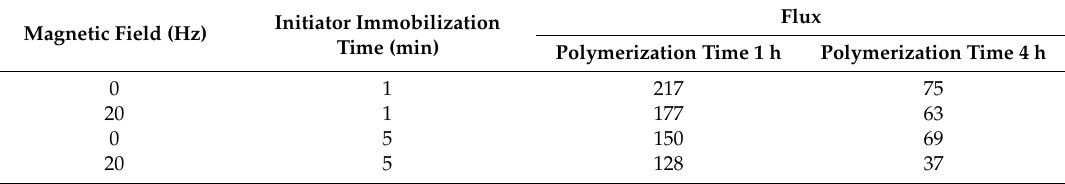
Table 2. Steady state deionized (DI) water flux (L m − 2 h − 1 ) during dead-end filtration.